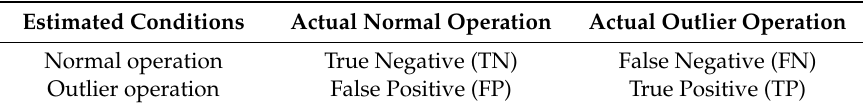
Table 1. Notations of four